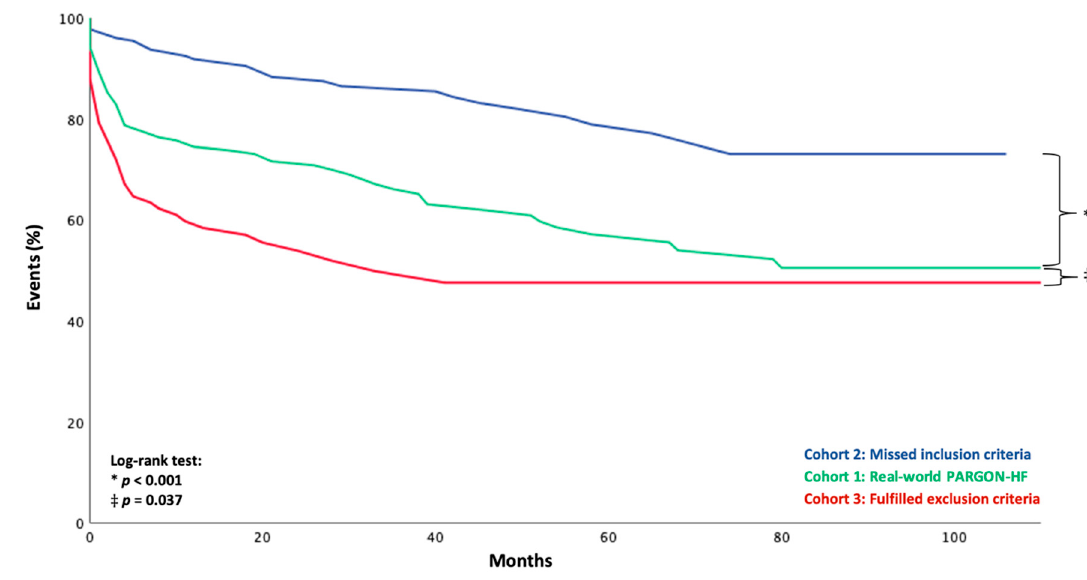
Figure 4. Kaplan–Meier plots for the composite endpoint of hospitalization for heart failure or death from cardiac causes according to eligibility for PARAGON-HF.